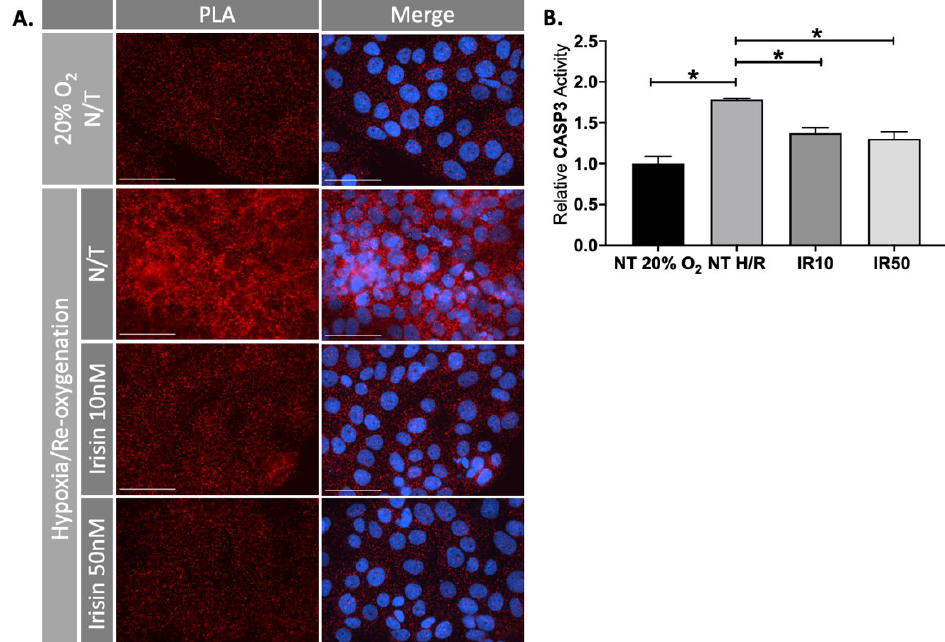
Figure 4. Irisin reduced apoptosis during ischemic injury in JEG-3 cells. ( A ) Proximity ligation assay (PLA) showed that the elevated APAF1/Cytochrome C interaction (apoptosis), as shown by red fluorescent molecules, under H/R condition was antagonized by Irisin in JEG-3 cells, similar to our observation in human 1st trimester explants. ( B ) This process coincided with the inhibition of Caspase 3 activity as confirmed by specific fluorogenic substrates Ac-DEVD-AMC (n = 3). (Significant changes in Caspase 3 activity were measured by a one-way analysis of variance and subsequent Tukey’s post hoc test to analyze differences between cohorts; * p < 0.05. Scale bar = 100 µ M. Blue fluorescent staining is for Dapi indicating the cell nucleus; Red fluorescent staining indicates APAF1 and Cytochrome C interaction. Bar plots are presented as mean ± SEM. N/T, non-treatment; PLA, Proximity Ligation Assay).